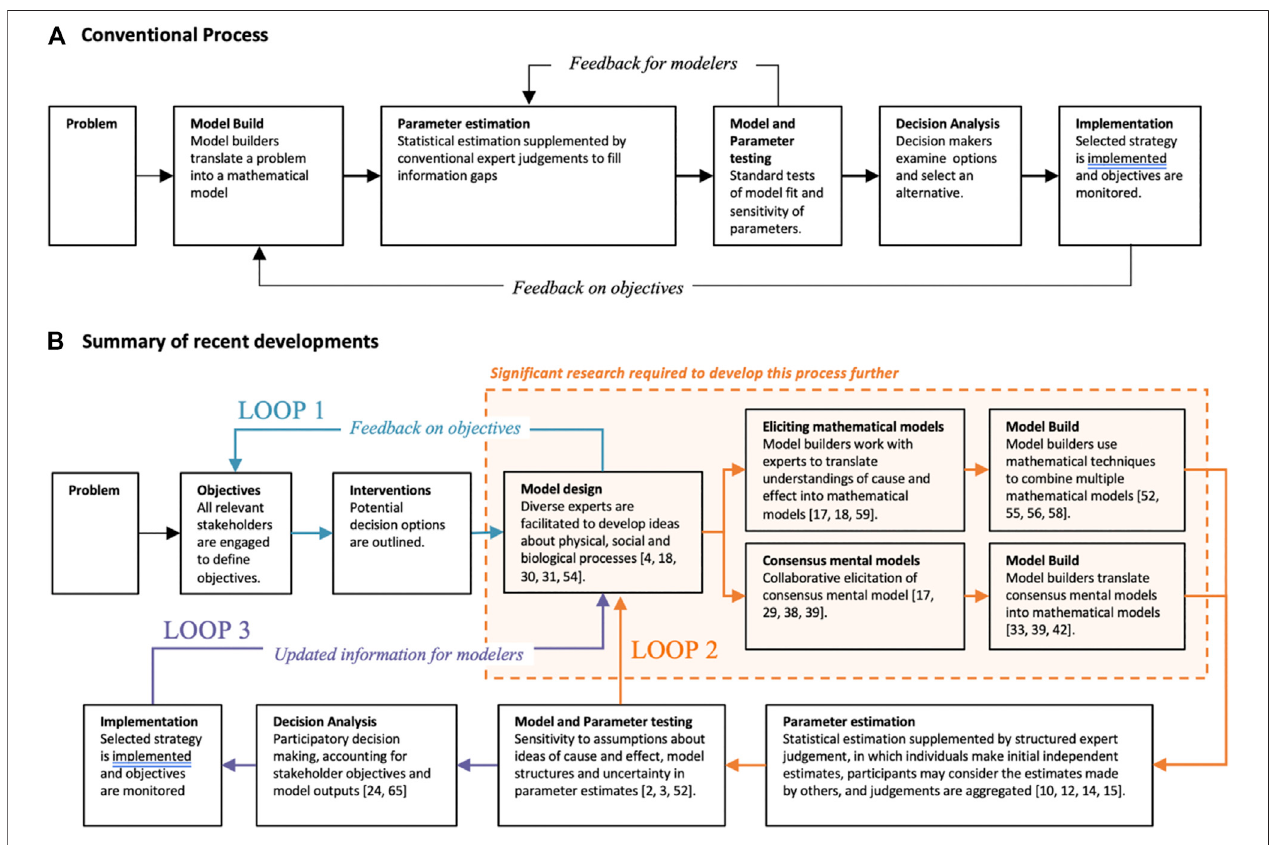
FIGURE 5 | Steps in model development for decision making, summarizing (A) processes deployed in our experience in most model developments, and (B) emerging approaches, expanding the outline in Figure 4 .